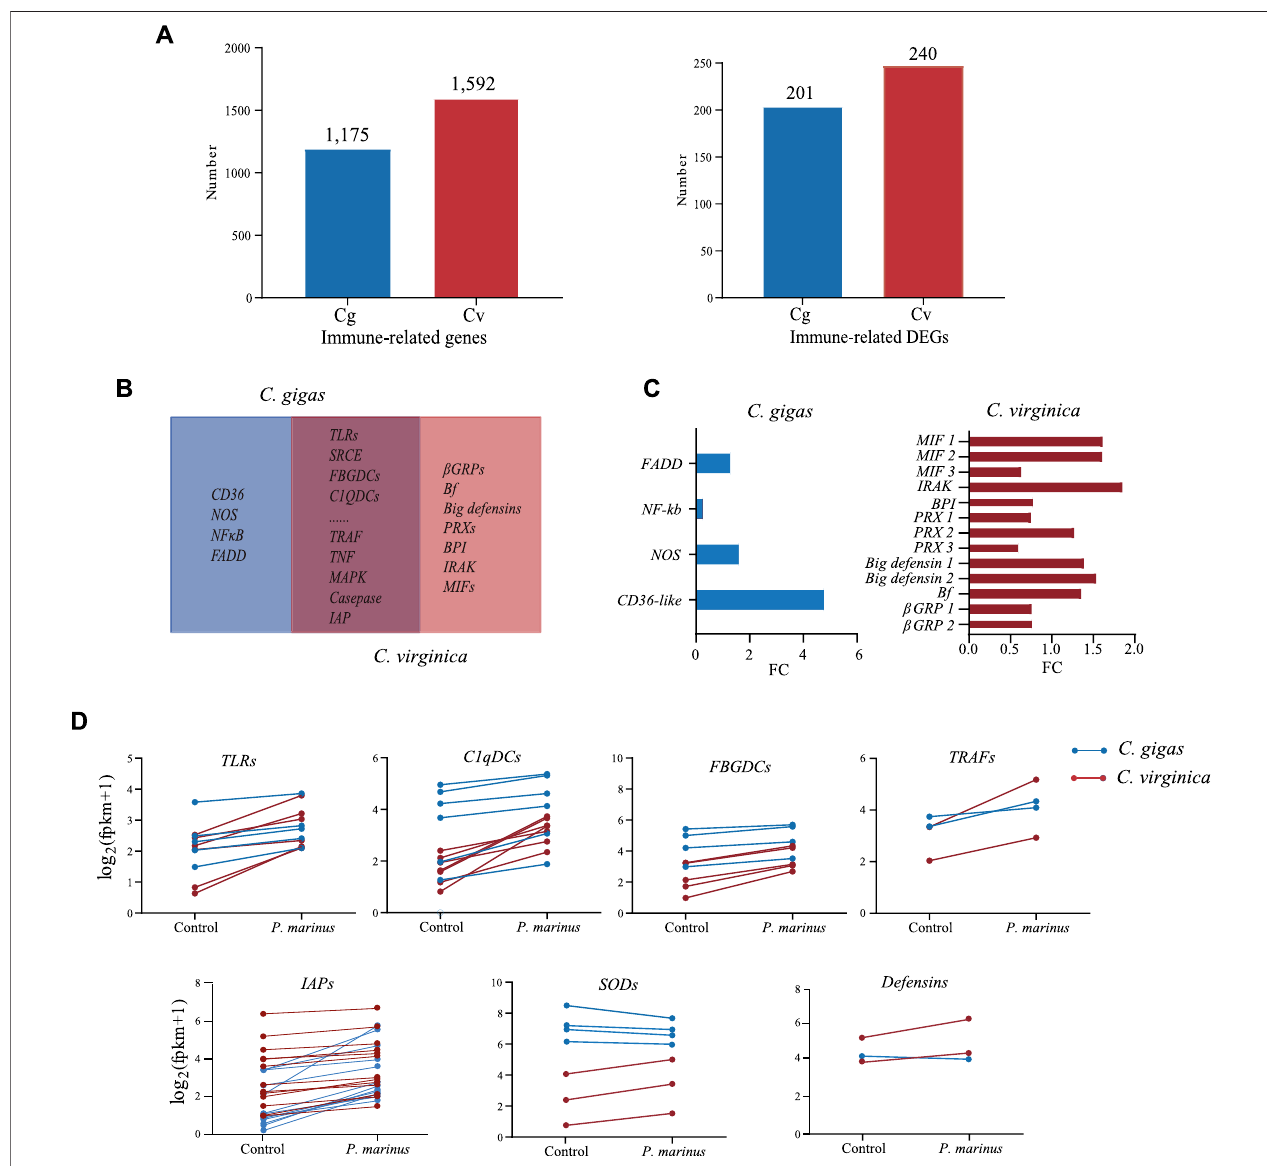
FIGURE 3 | Comparative transcriptome analysis between C. gigas and C. virginica under P. marinus challenge. (A) , Number of immune-related genes identi fi ed (Left) and number of immune-related genes differentially expressed (Right) in C. gigas (Cg) and C. virginica (Cv). (B) , Venn diagrams of differentially expressed immune genesunder P. marinus challenge betweenthe twooysterspecies. (C) ,Uniqueand differentially expressed immune genesinducedby P. marinus intwooyster species. (D) , Transcriptional change of differentially expressed immune genes shared by two oyster species, including pattern recognition receptors (e.g., TLRs ) and immune effectors (e.g., TRAFs